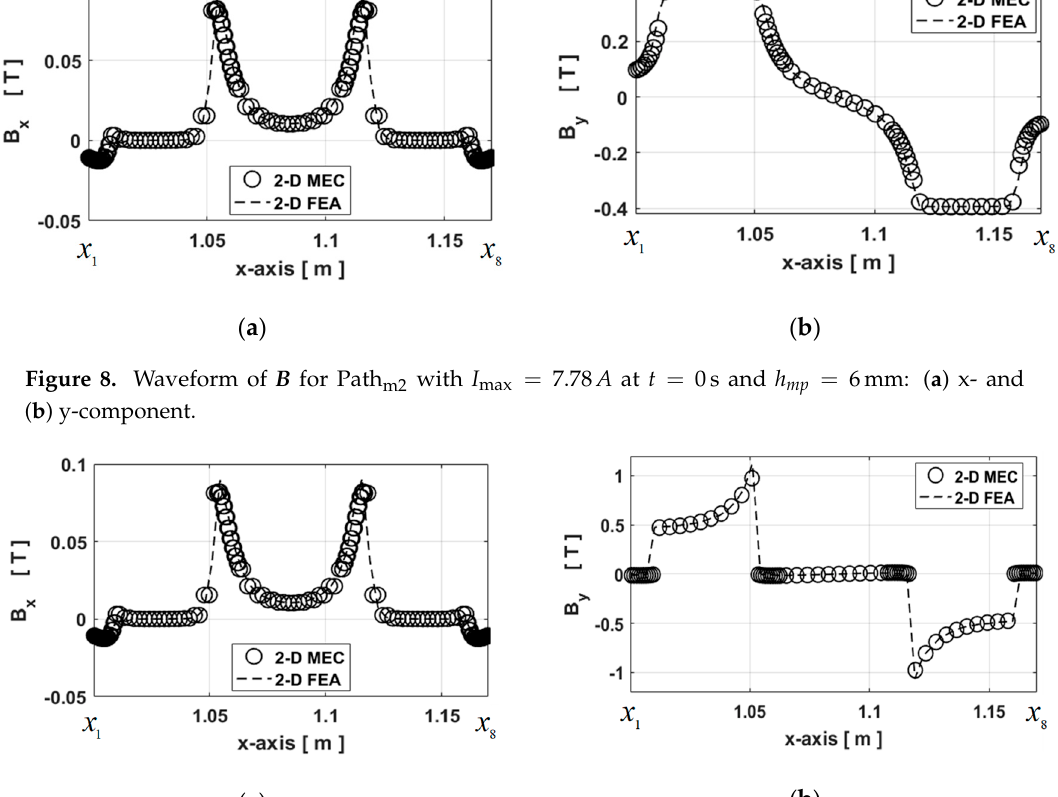
Figure 9. Waveform of B for Path m3 with I max = 7.78 A at t = 0s and h mp = 6mm: ( a ) x- and ( b ) y-component.